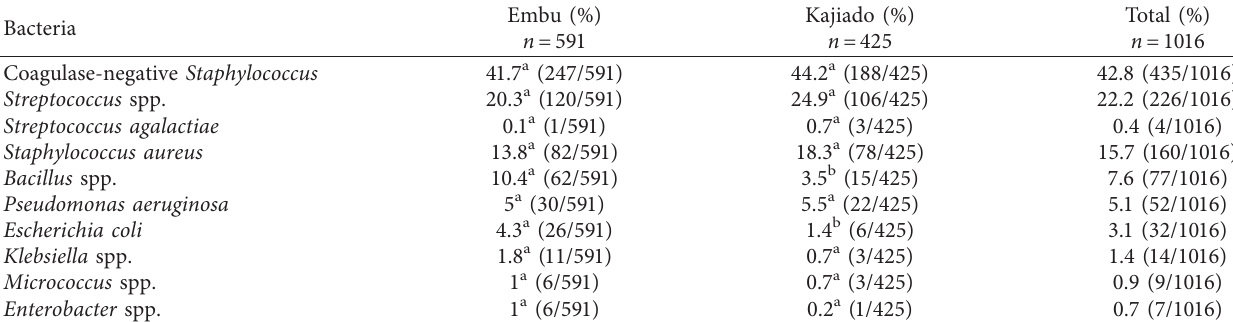
Table 2: Effect of counties on the prevalence of mastitis